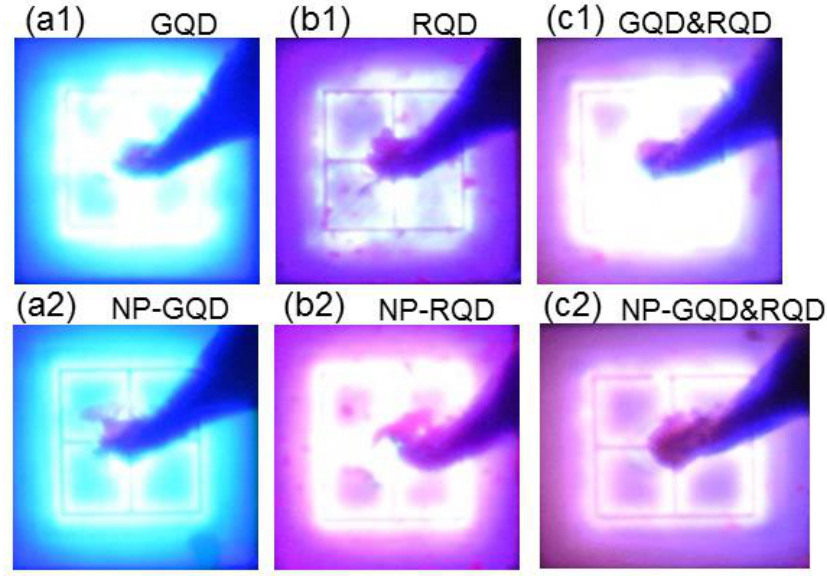
Figure 9. ( a1 )–( c1 ) and ( a2 )–( c2 ): Photographs of the lit LEDs of samples GQD, RQD, and GQD&RQD Figure 9. ( a1 ) – ( c1 ) [( a2 ) – ( c2 )]: Photographs of the lit LEDs of samples GQD, RQD, and GQD&RQD (NP-GQD, NP-RQD, and NP-GQD&RQD), respectively, when the injected current is 100 mA.